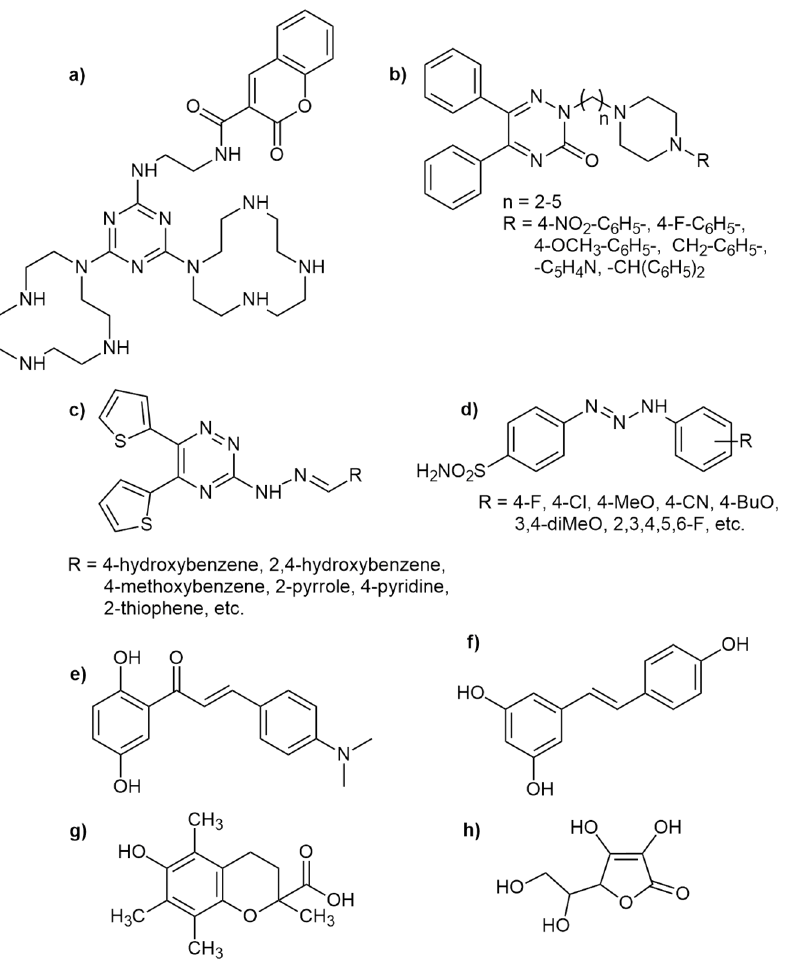
Figure 1. Examples of diversity of antioxidants with high activity: ( a ) 1,3,5-triazine bridged small molecule [3]; ( b ) biphenyl-3-oxo-1,2,4-triazine linked piperazines [26]; ( c ) arylidene hydrazine derivatives of substituted 1,2,4-triazine [27]; ( d ) substituted aminobenzene sulfonamides [28]; ( e ) chalcone derivative [29]; ( f ) resveratrol [4]; ( g ) trolox [4]; ( h ) ascorbic acid [4].